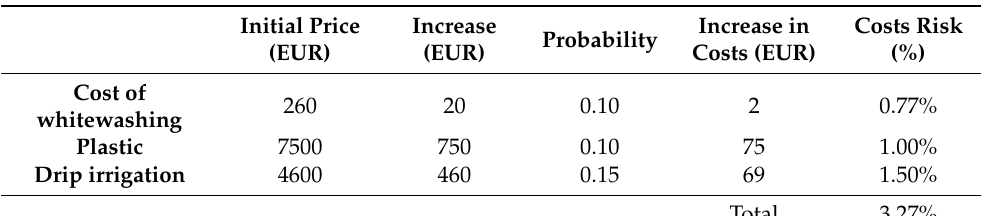
Table 6. Summary of risk of increase in costs.